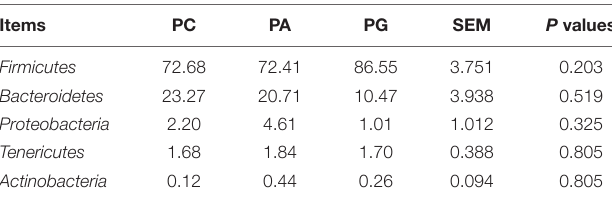
TABLE 11 | Effects of B. licheniformis and enramycin on relative abundances of phyla in cecal microbiota of 25-day-old broilers challenged with SNE (%).